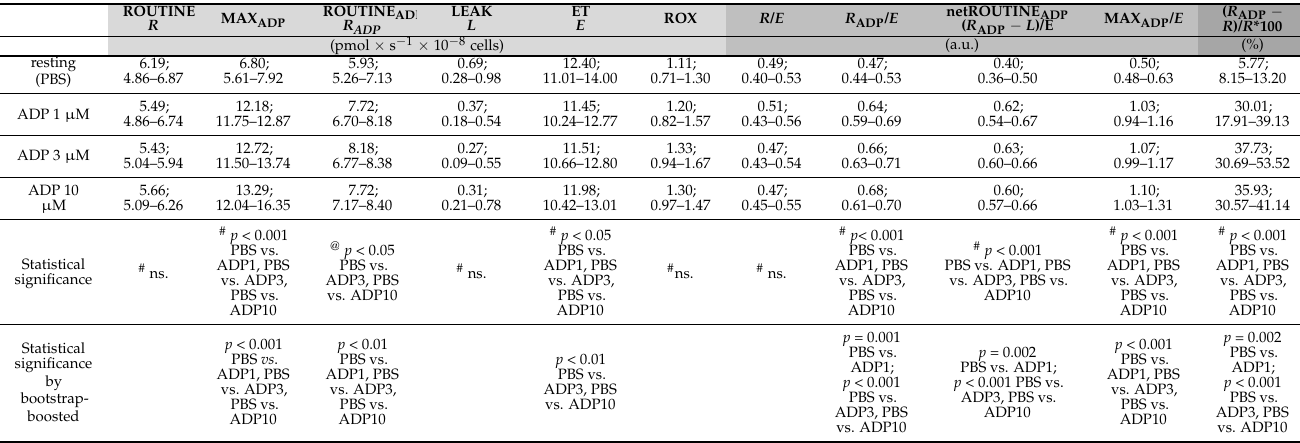
Table 4. Mitochondrial respiration parameters, control ratios and non-mitochondrial respiration of resting and ADP- stimulated